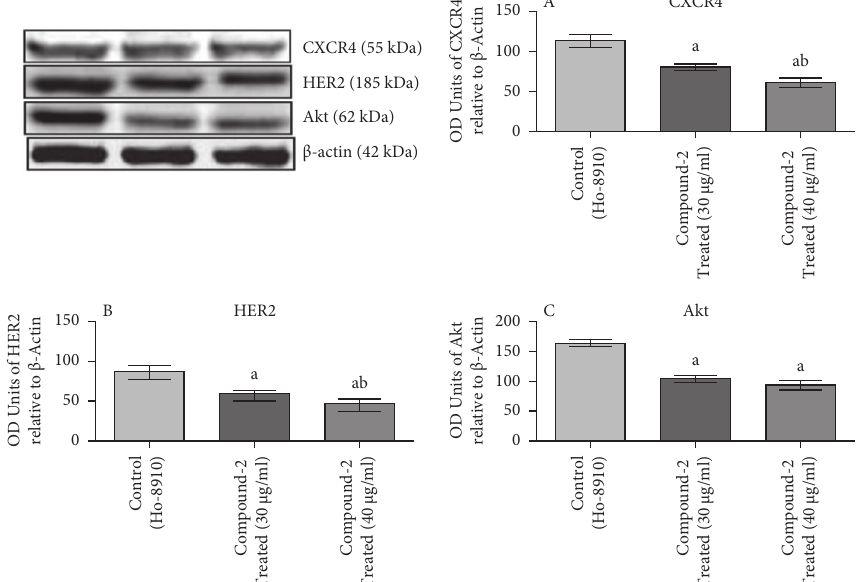
Figure 9: Effect of compound 2 on C-X-C motif chemokine receptor 4 (CXCR 4), human epidermal growth factor receptor 2 (HER2), and Akt protein expression in HO-8910 cells. Cells were treated with 30 and 40 μ g of compound for 24 h. The protein levels were quantified using densitometry analysis and are expressed in relative intensity arbitrary unit. Each bar represents mean ± SEM of six independent obser- vations. (a) Compared to control; (b) compared to 30 μ g of compound 2.